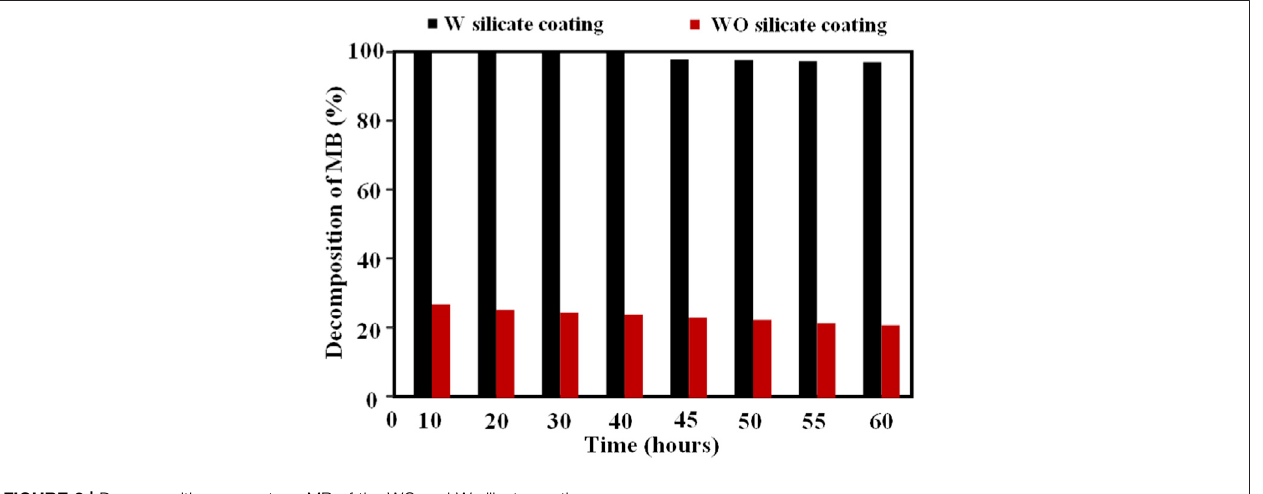
FIGURE 8 | Decomposition percentage MB of the WO and W silicate coatings.